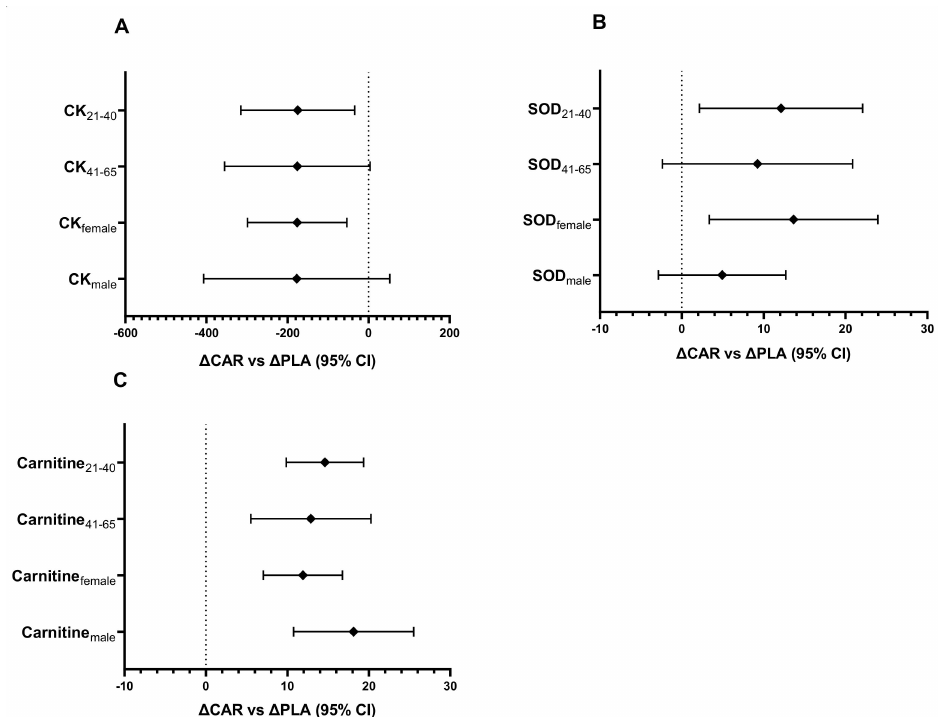
Figure 9. CK ( A ), SOD ( B ), and carnitine ( C ) ∆ CAR vs. ∆ PLA (95% CI). The 95% confidence intervals of the between group difference for the relative change from Wk5-Pre to Wk5-Post ( ∆ CAR vs. ∆ PLA) by age and gender groups for CK ( A ), and the between-group difference for the relative change from Pre to Wk5-Post ( ∆ CAR vs. ∆ PLA) by gender and age groups for SOD ( B ) and carnitine ( C ) are shown. The groups are carnitine (CAR) and placebo (PLA). Abbreviations: CK = creatine kinase; SOD = superoxide